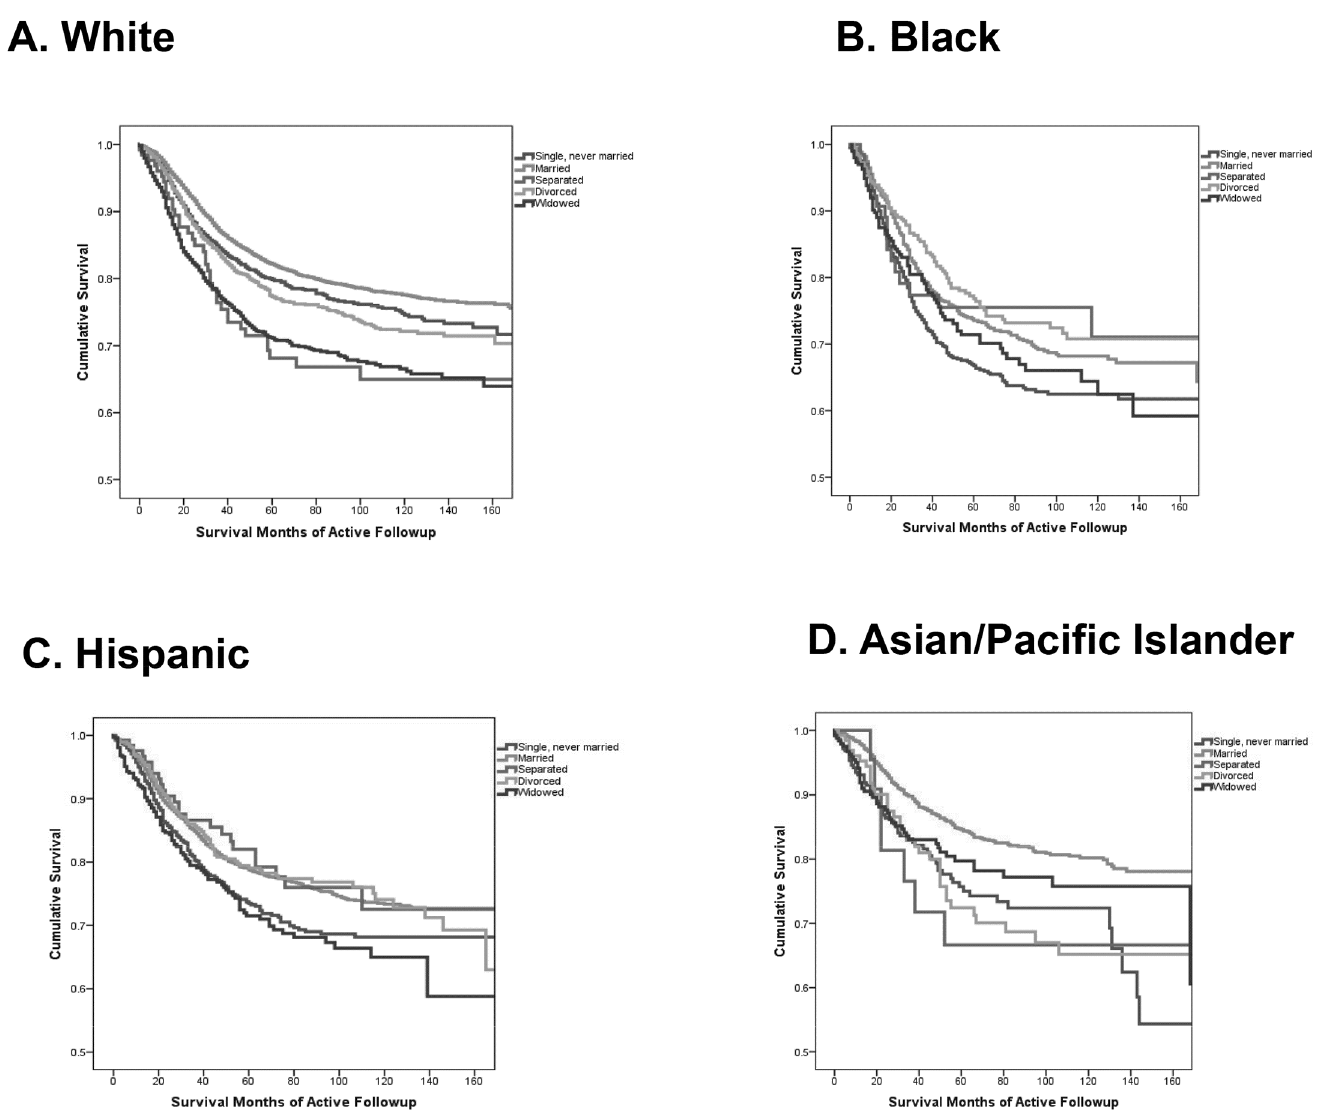
Fig 1. Unadjusted Kaplan-Meier breast cancer specific survival for single, married, separated, divorced, and widowed women with TNBC who were white (Panel A), black (Panel B), Hispanic (Panel C), and Asian/Pacific Islander (Panel D).